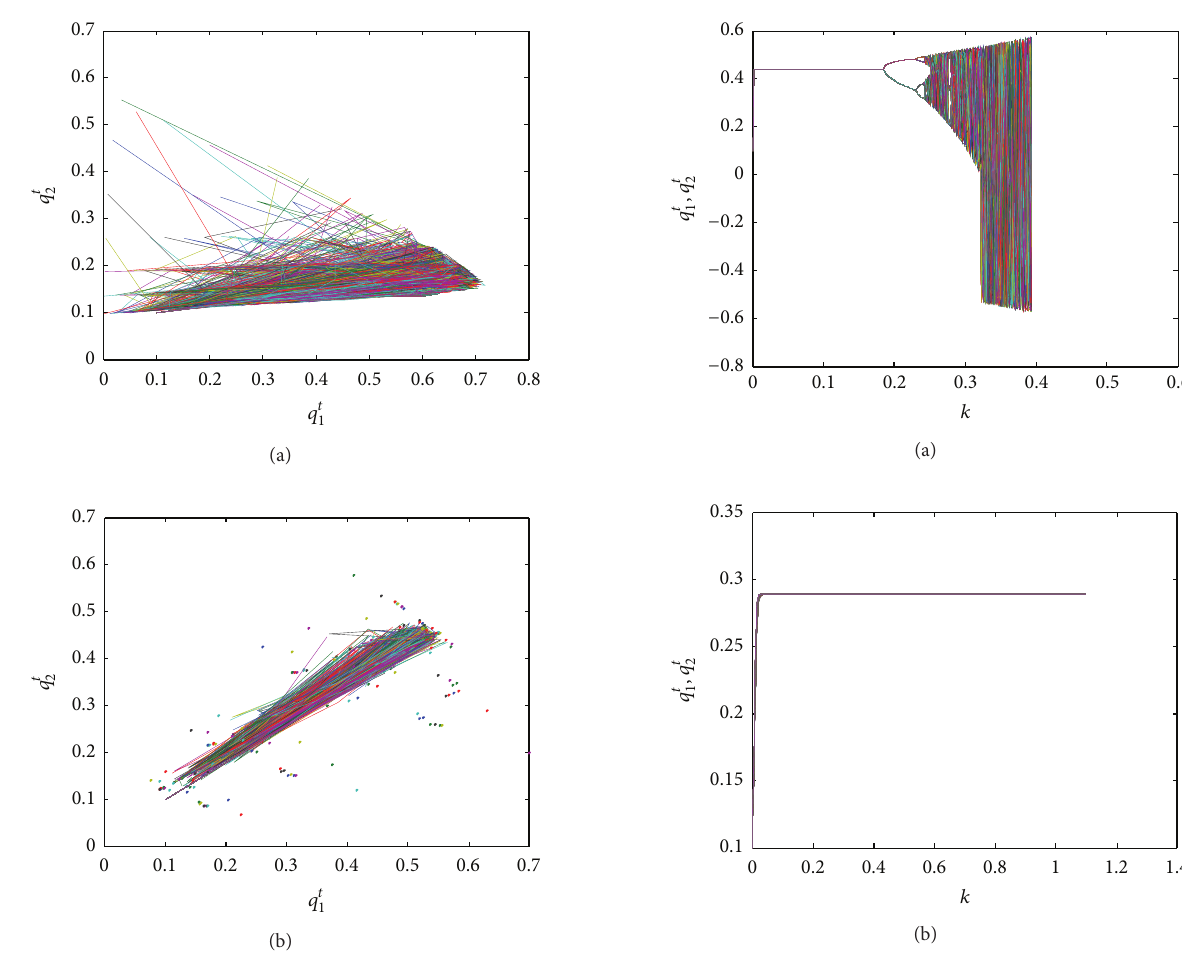
be stable, the eigenvalues should satisfy |𝜆 𝑖 | < 1 , 𝑖 = 1, 2 , that is, 𝑘 < 1/(2(𝑎 − 𝑐 − 𝛾𝜀 1 )) < 2/(𝛾𝜀 2 − (1/5)(4𝑎 − 4𝑐 + 𝛾𝜀 1 )) ,